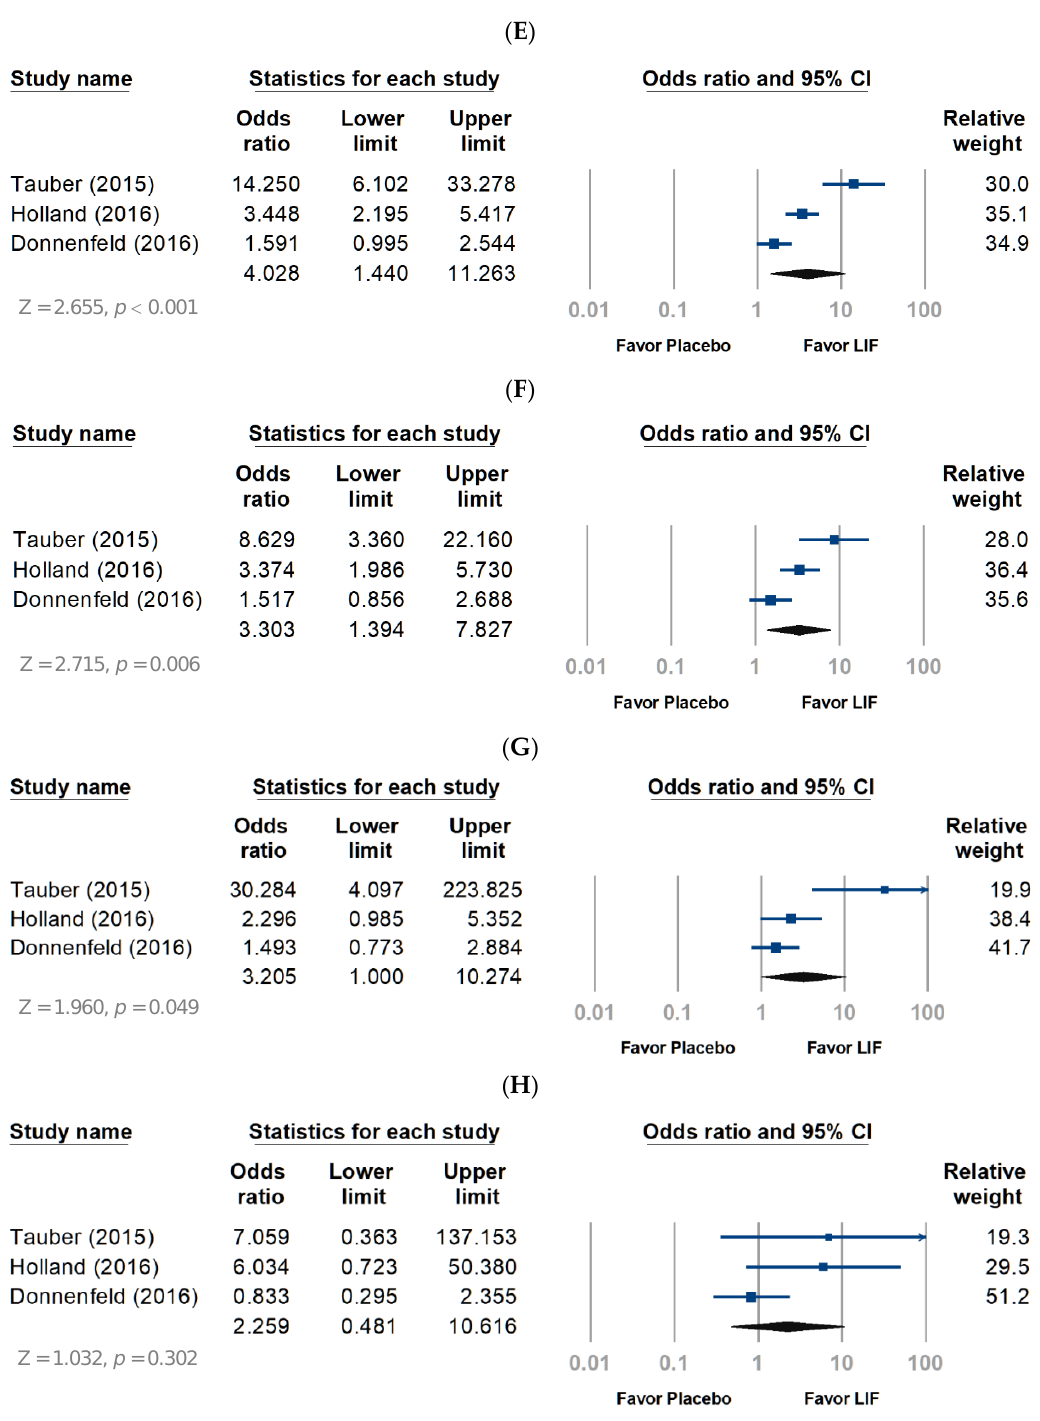
Figure 4. Pooling ocular and non-ocular adverse events (AEs) of lifitegrast treatment. LIF, lifitegrast. ( A ) Ocular AEs, overall. ( B ) Ocular AEs, mild. ( C ) Ocular AEs, moderate. ( D ) Ocular AEs, severe. ( E ) Non-ocular AEs, overall. ( F ) Non-ocular AEs, mild. ( G ) Non-ocular AEs, moderate. ( H ) Non- ocular AEs, severe.